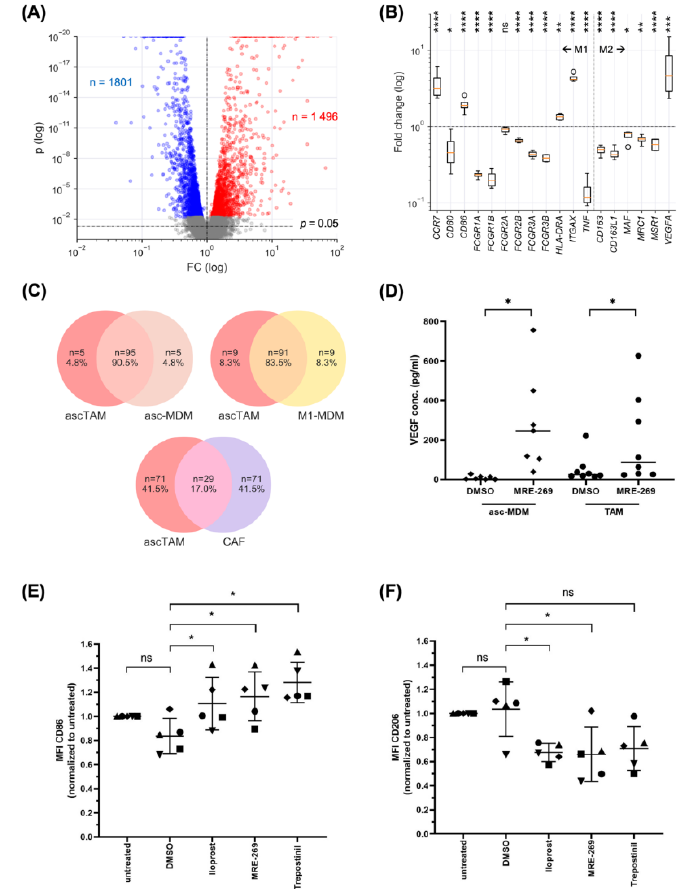
Figure 4. Regulation of the transcriptome and polarization state of macrophages by PGI 2 analogs. ( A ), Volcano plot depicts genes regulated by MRE-269. ascTAM were treated with 1 µM MRE-269 or solvent control (DMSO) for 5 h and analyzed by RNA-Seq. Red: sites upregulated by MRE-269 relative to solvent control (FC > 1 and FDR < 0.05). Blue: downregulated sites (FC < 1 and FDR < 0.05). Grey: FDR ≥ 0.05. ( B ) Expression of M1 and M2 marker genes, expressed as the fold change of MRE-269-treated cells relative to solvent control (RNA-Seq data; n = 4 biological replicates). Boxplots show the median (line), upper and lower quartiles (box), range (whiskers) and outliers (circles). * FDR < 0.05; ** FDR < 0.01; *** FDR < 0.001; **** FDR < 0.0001; ns, not significant by EdgeR paired test. ( C ) Venn diagrams illustrating the overlaps of gene sets upregulated by MRE-269 in ascTAM, TAM-like MDM differentiated in the presence of ascites (asc-MDM) and M1-polarized MDM (top 100 genes by FDR in each case). ( D ) Secretion of VEGF by ascTAM and asc-MDM after stimulation with 100 nM MRE-269 under serum-free conditions measured by ELISA. DMSO: solvent control. Horizontal bars indicate the mean. * p < 0.05 by paired t test. ( E , F ) Flow cytometry analysis CD86 ( E ) and CD206/MRC1 ( F ) on asc-MDM treated with 100 nM of the PGI 2 analogs MRE-269, iloprost or trepostinil for 24 h. MFI was expressed relative to untreated controls. Horizontal bars show the mean. * p < 0.05; ns: non-significant by paired t